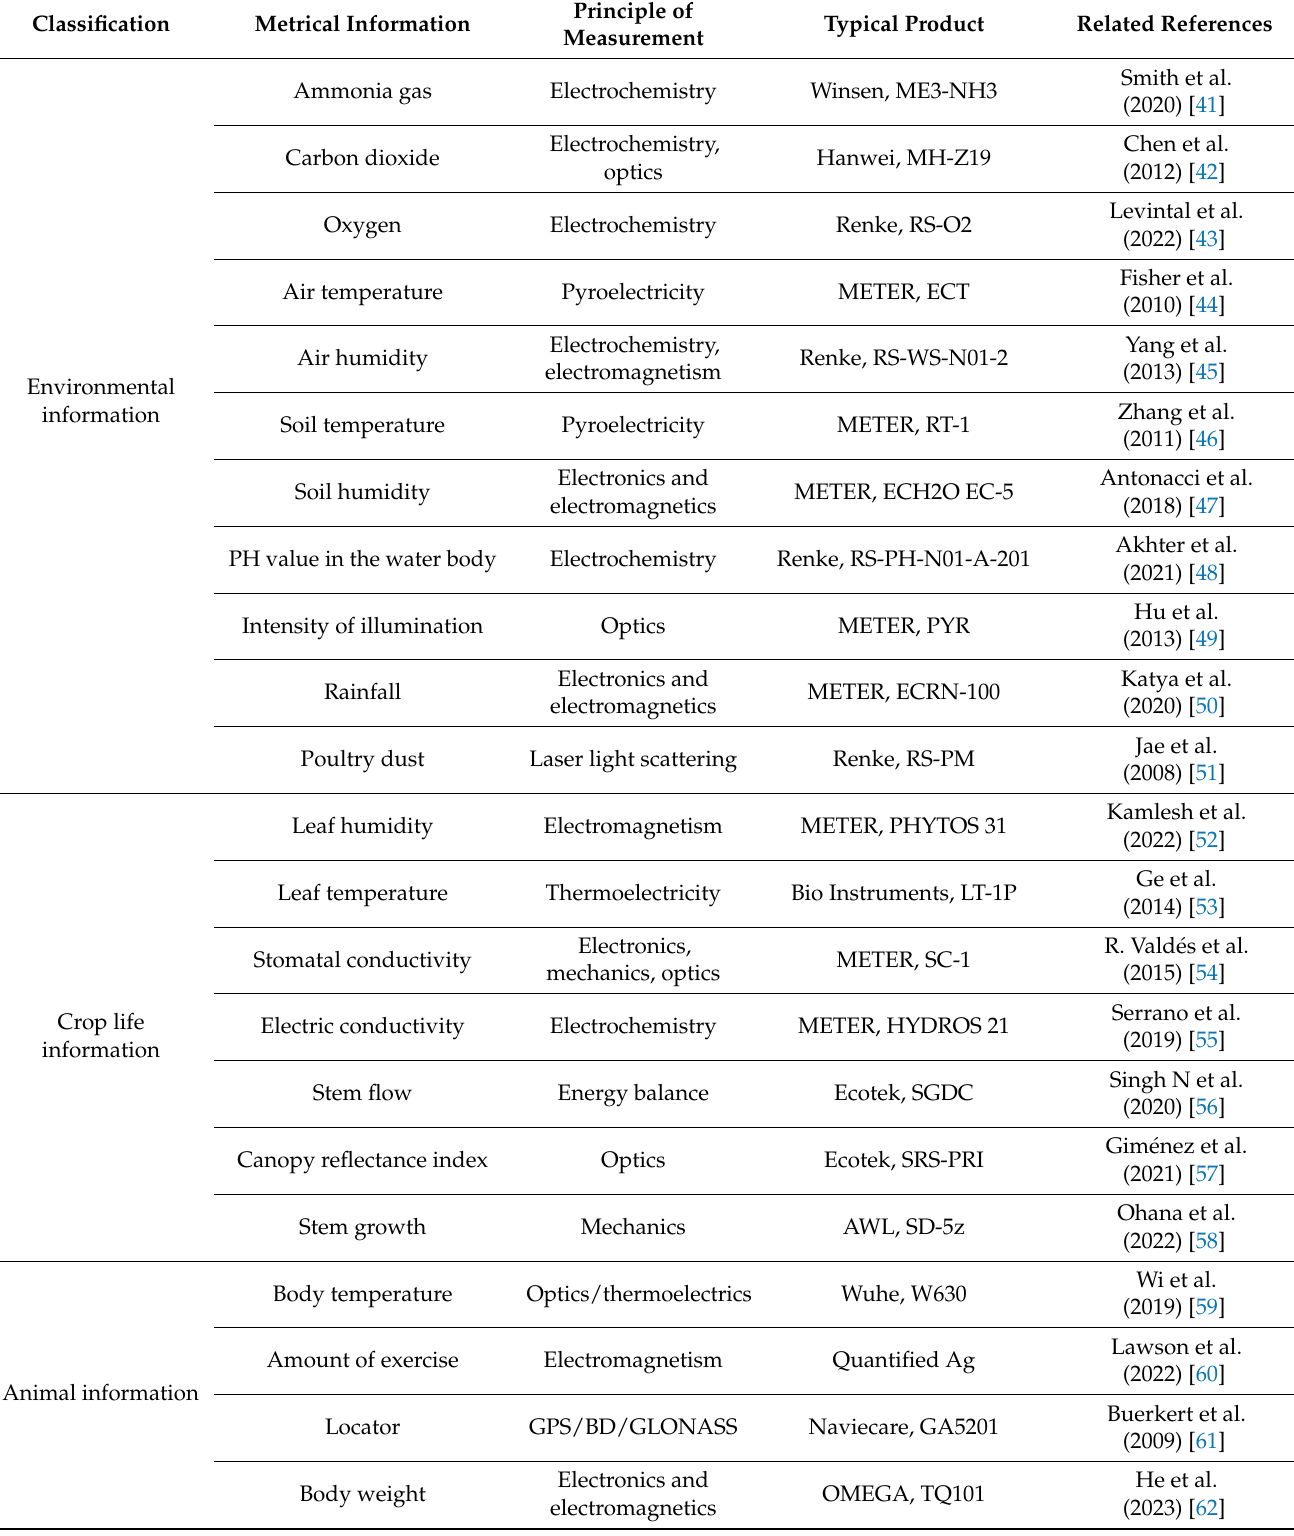
Table 2. Representative agricultural sensors in a variety of Ag-IoT